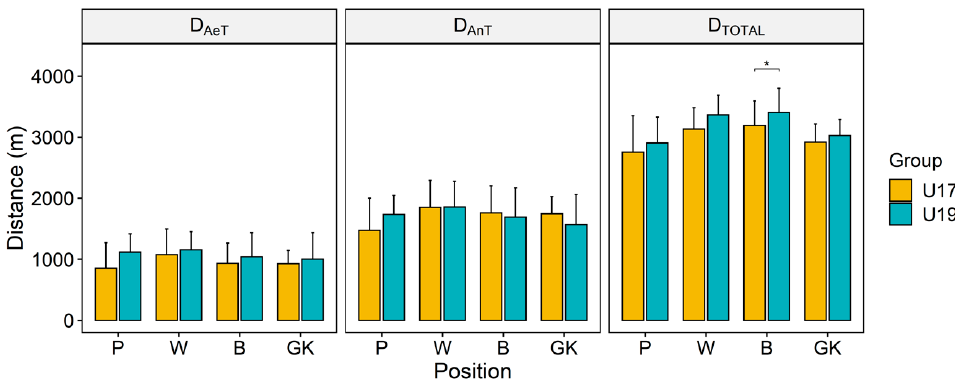
Figure 3. Distance covered by the players at different intensity zones in the endurance test.